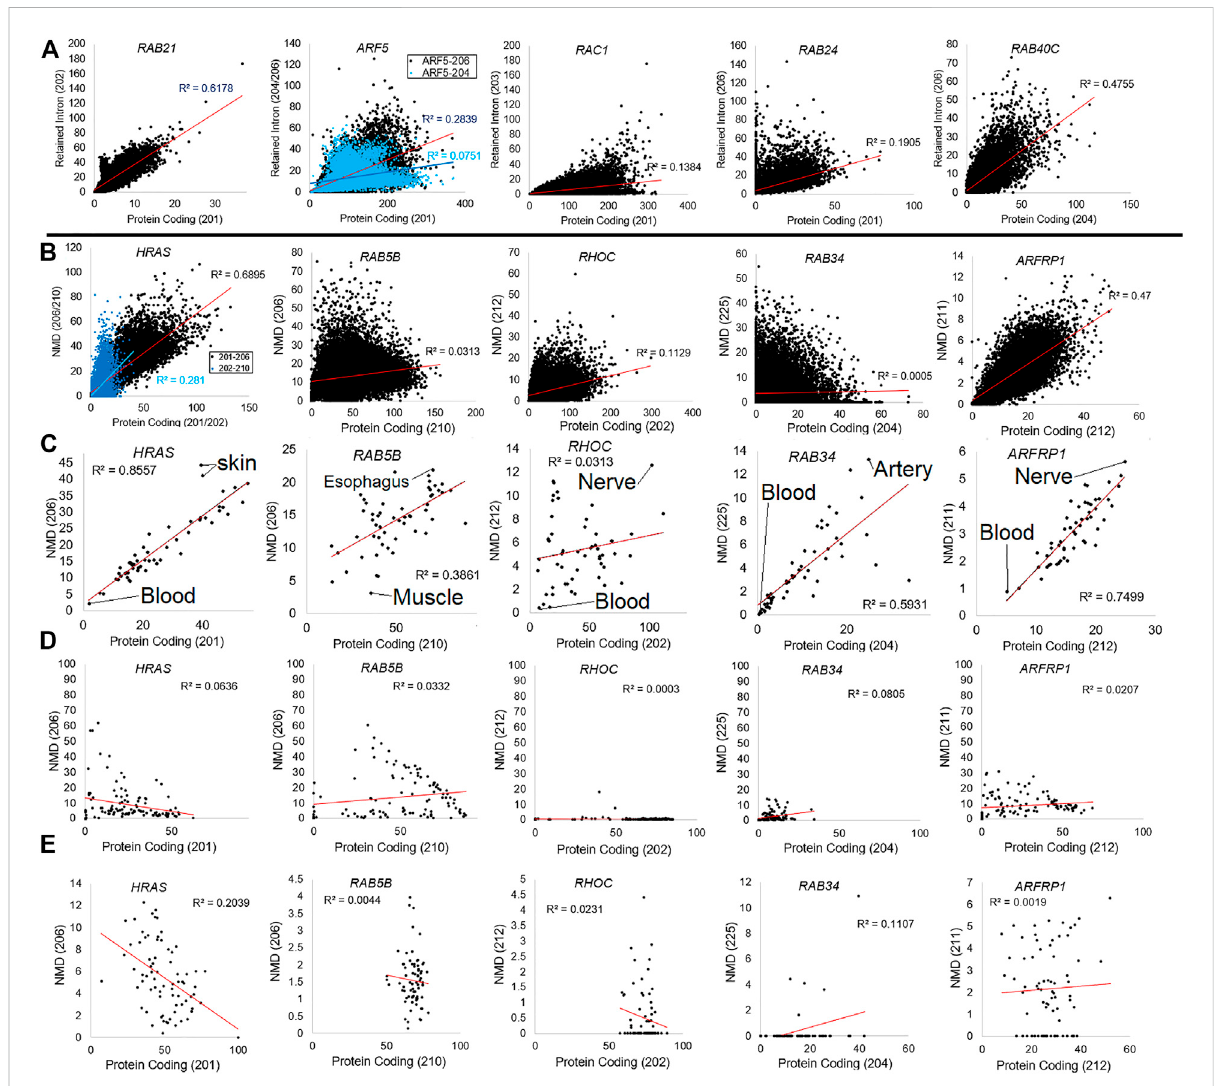
FIGURE 8 Examples of genes with retain intron or nonsense-mediated decay dynamics. (A) Plotting of fi ve representative genes ( RAB21 , ARF5 , RAC1 , RAB24 , and RAB40C ) for the top protein coding isoform ( x -axis) relative to the retained intron isoform ( y -axis) for all samples of GTEx. Values are shownastranscriptspermillion(TPM).TheR-squaredcorrelationforeachpanel ’ sbest fi tlineislisted. (B) Plottingof fi verepresentativegenes( HRAS , RAB5B , RHOC , RAB34 , and ARFP1 ) for the top protein coding isoform ( x -axis) relative to the nonsense-mediated decay isoform ( y -axis) for all samples of GTEx. (C) Compiled value for all samples within a tissue of GTEx with top tissues labeled. (D) Analysis of each gene ’ s percent NMD transcript ( y -axis) relative to protein-coding ( x -axis) averaged for each BioProject of “ Blood PAXgene ” samples. (E) Representative data